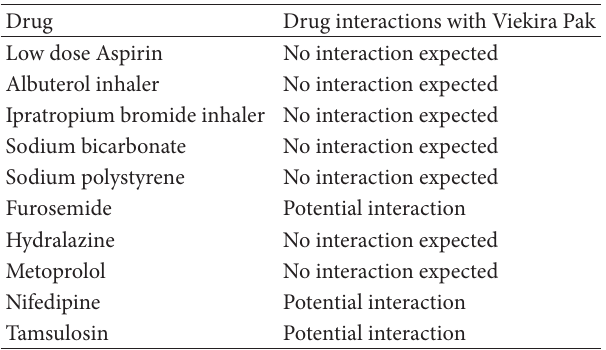
Table 1: Summary of the anticipated drug-drug interactions between the patient’s current medications and Viekira